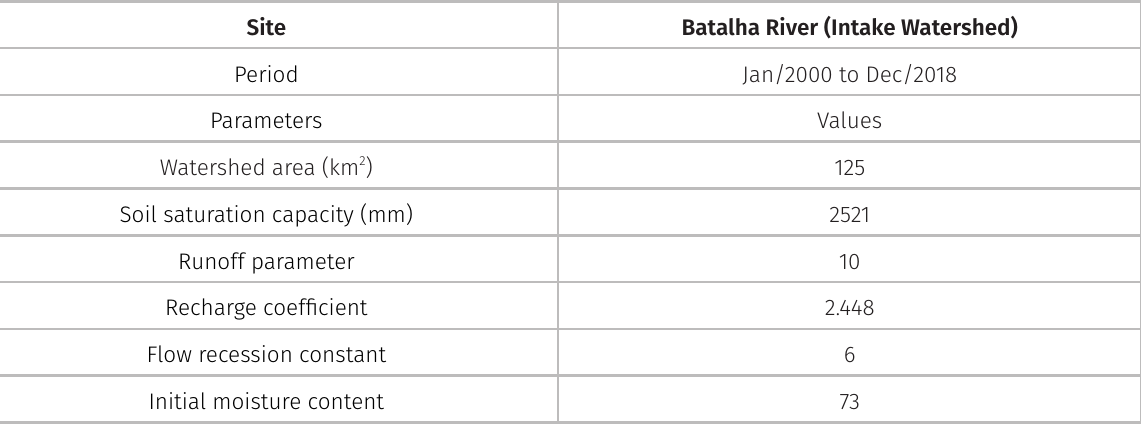
Table III. Calibration